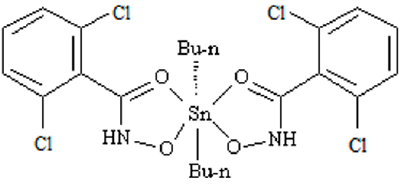
Figure 1. The structure of di- n -butyl-di-(4-chlorobenzohydroxamato)tin (DBDCT).